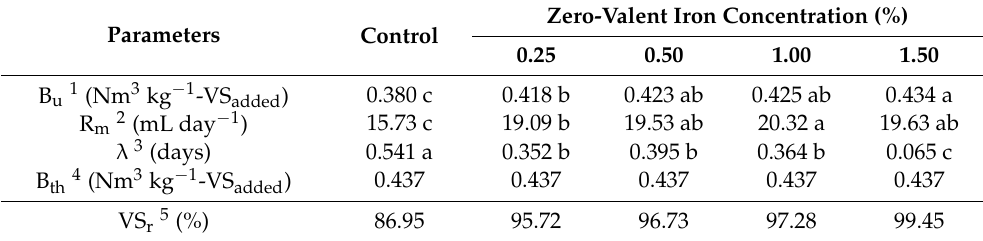
Figure 1. Methane yield curves optimized by the modified Gompertz model at different concentra- tions of zero-valent iron, Fe 0 (ZVI). Table 3. Analysis of methane yield characteristics via the modified Gompertz model at different concentrations of zero-valent iron, Fe 0 (ZVI).